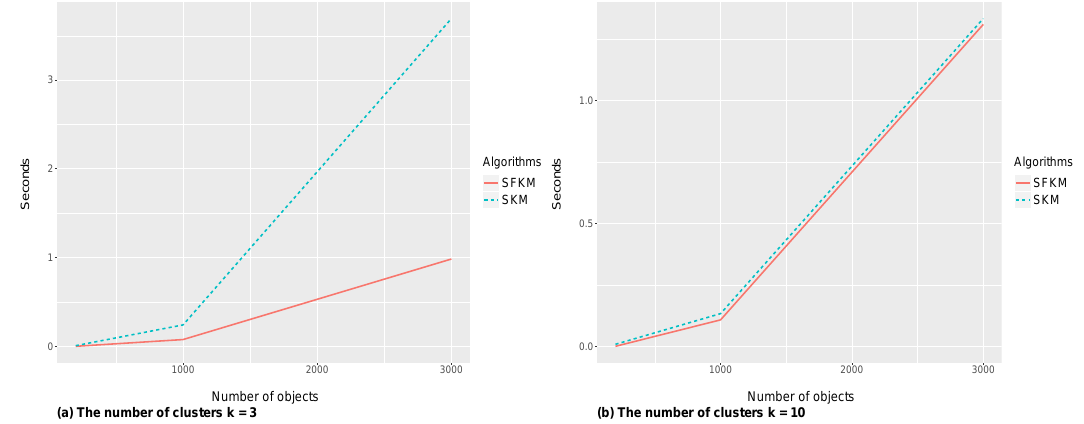
Figure 2. Benchmarking of the SKM and SFKM for k = 3 ( a ) and k = 10 ( b